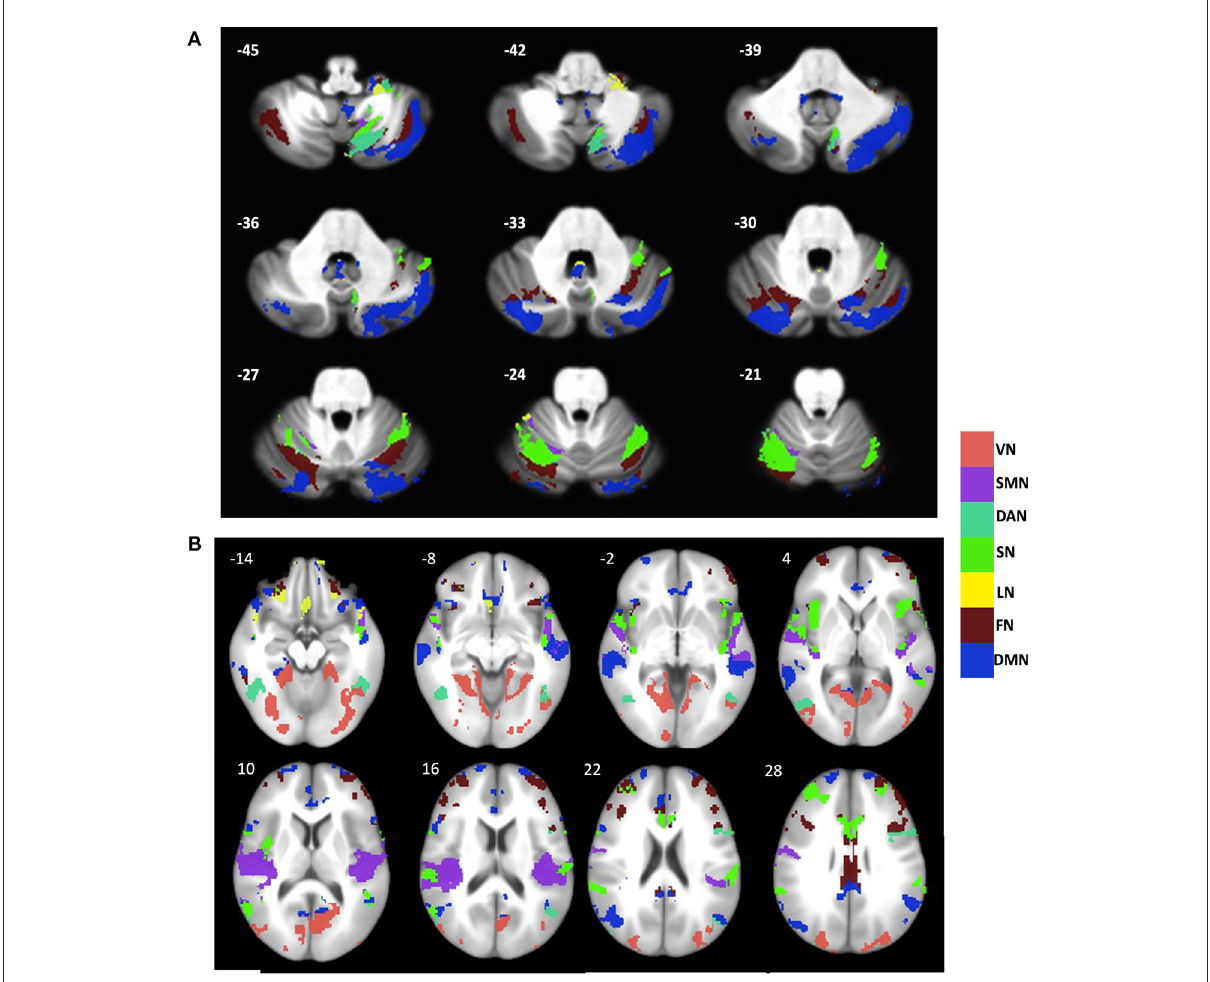
FIGURE1 Distribution of gray matter atrophy pattern across major brain networks in the (A) cerebellum and (B) cerebral cortex in svMCI. The brain network parcellation was adopted from Buckner atlas for cerebellum (Buckner et al., 2011) and Yeo atlas for cerebral cortex (Yeo et al., 2011). VN, Visual network; SMN, Somatomotor Network; DAN, Dorsal Attention Network; SN, Salience Network; LN, Limbic Network; FN, Frontal Network; DMN, Default Mode Network.